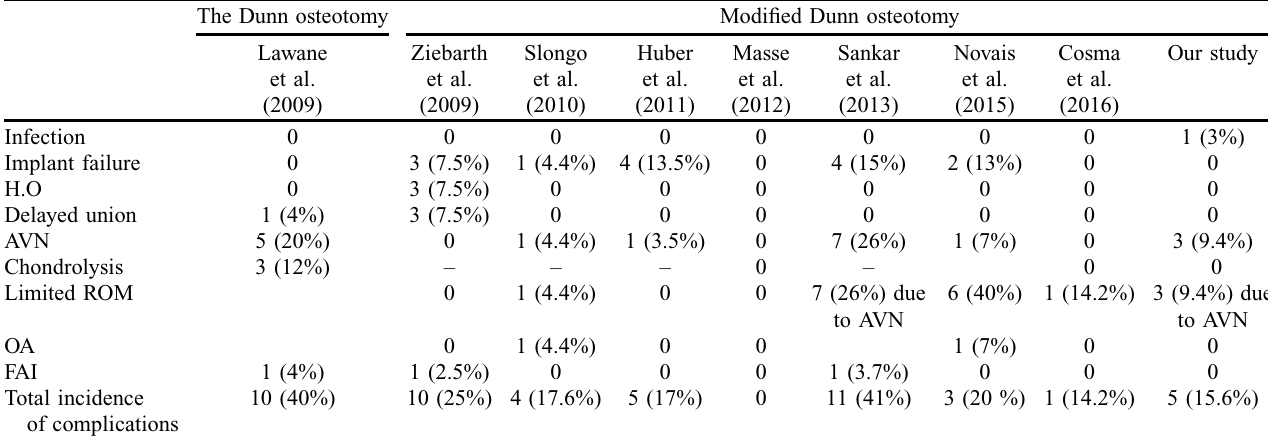
Table 6. Comparison of the incidence of postoperative complications in different